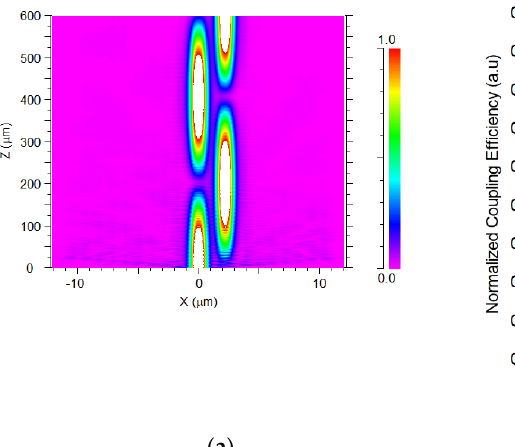
Figure 2. Normalized coupling efficiency as a function of the geometrical parameters of the multicore photonic crystal fiber (PCF) (d/ Λ ) for the operating wavelengths.